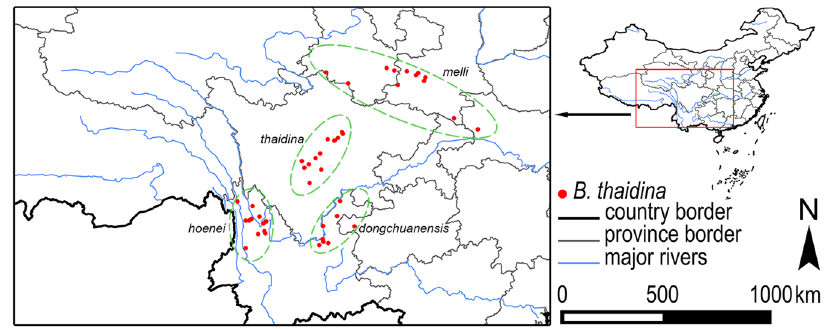
Figure 2. Distribution of the presence data points of B. thaidina in China with designation of subspecies